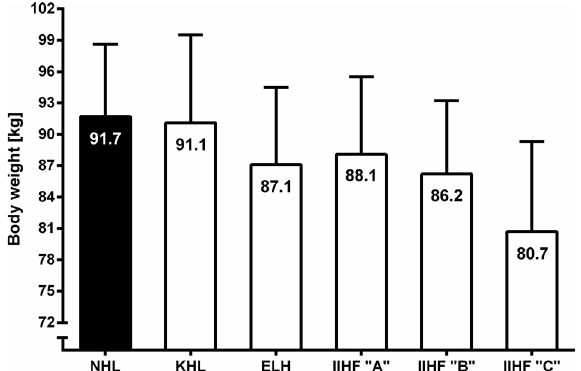
Figure 2. Values of body weight of current players of ice hockey Canadian-American NHL, players of the Russian KHL, players of the Czech ELH and players in the world ranking by performance level